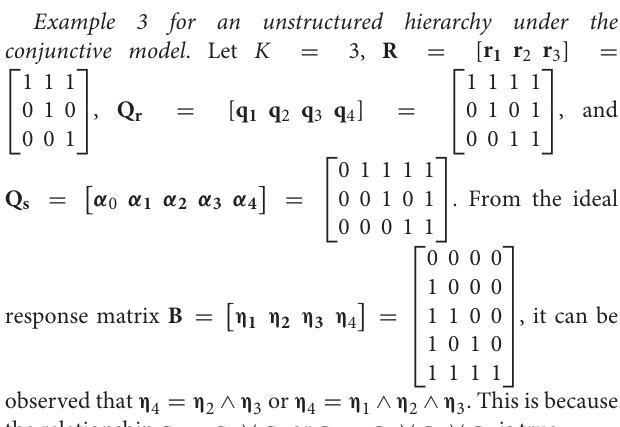
The bold values are larger than 0.9. TABLE 3 | The correct recovery rates of q-entries with sample size of 300 for the DINA model and optimal design. Item parameters for the R